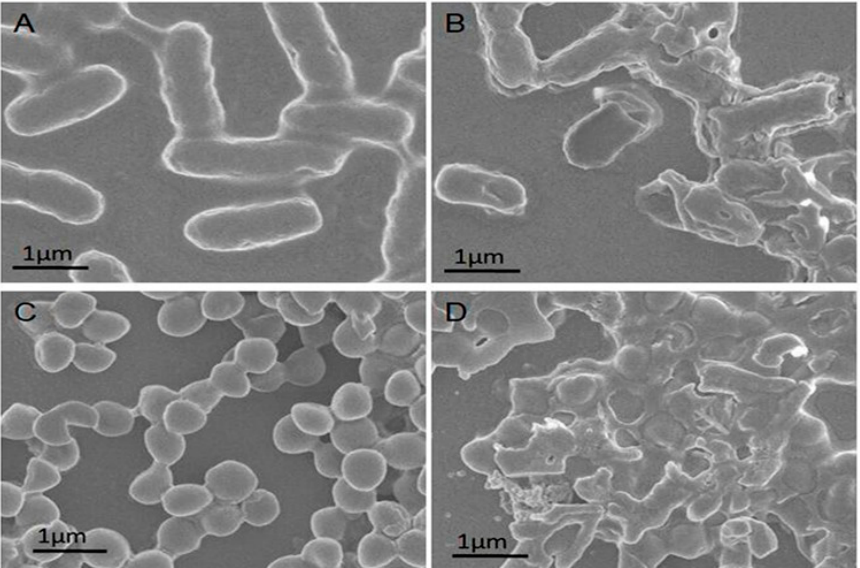
Figure 2. SEM images of ( A ) untreated Escherichia coli, ( B ) E. coli treated with protease-conjugated gold nanorods (PGs) (50 µ g / mL), ( C ) untreated Staphylococcus aureus, and ( D ) S. aureus incubated with PGs (50 µ g / mL) and near infrared (NIR) illumination for 20 min. Reproduced from [40], with permission from Medical Press, 2019.